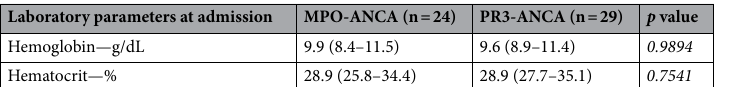
Table 5. Hemoglobin levels and hematocrit in MPO-ANCA and PR3-ANCA-associated renal vasculitis. Continuous variables are expressed as median and IQR, the Mann–Whitney U test was used for group comparisons to determine differences in